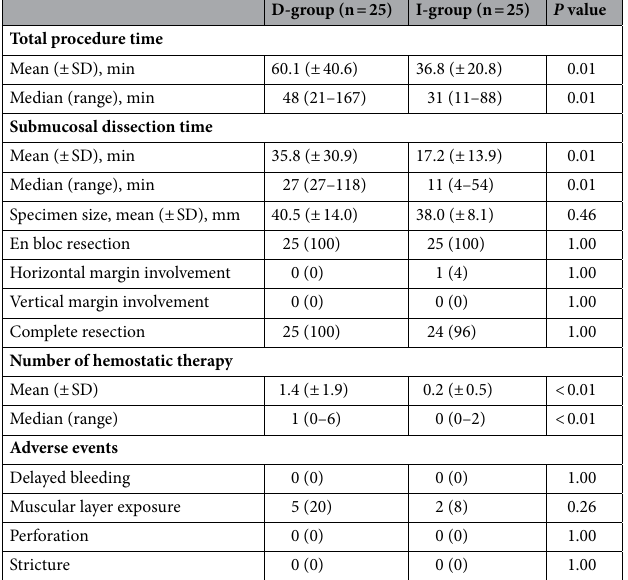
Table 2. Comparison of procedure-related outcomes between the D-group and the I-group. Values are n (%) unless otherwise indicated. D-group Dual knife group, I-group IT knife nano group, SD standard deviation.